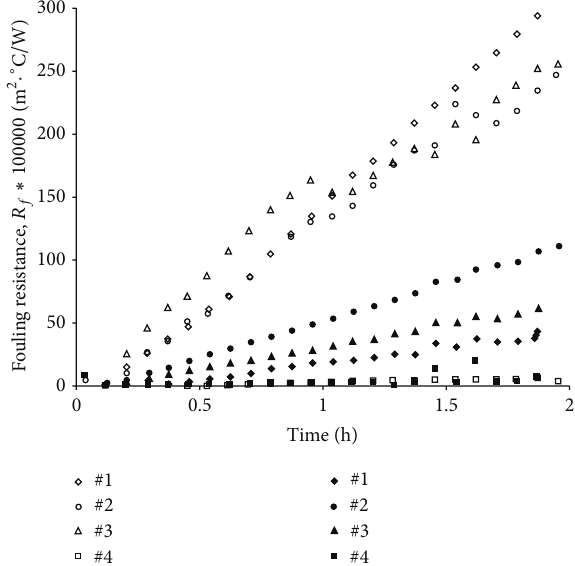
Figure 9: Fouling resistance evolution with time measured along the PHE. Various symbols refer to various fouling runs with varying thermal profiles and various calcium content for the 1% w/w WPI solutions (closed symbols: 100ppm calcium; open symbols: 120 ppm calcium) (# 𝑖 corresponds to the thermal profile number given in Figure 4 and Table